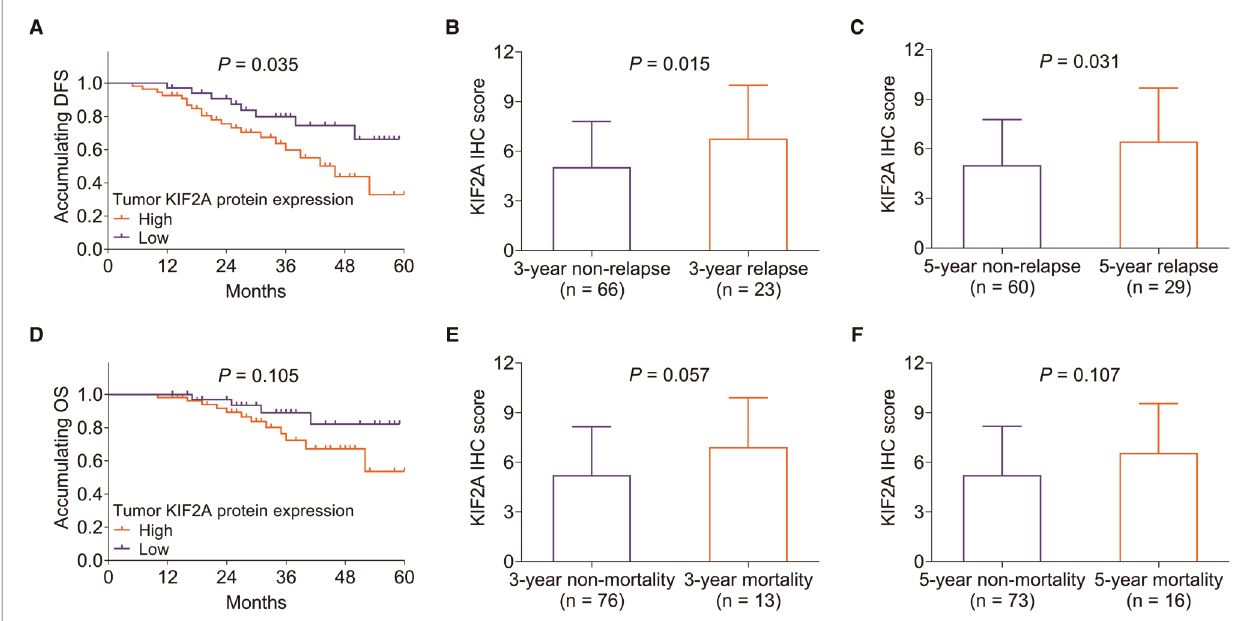
FIGURE 2 | Association of tumor KIF2A protein expression with DFS and OS. The association of tumor KIF2A protein expression with accumulating DFS in BLBC patients ( A ); the difference of KIF2A IHC score between relapsed BLBC patients and non-relapsed patients within 3 years ( B ) and 5 years ( C ). The association of tumor KIF2A protein expression with accumulating OS in BLBC patients ( D ); the difference in KIF2A IHC score between BLBC deaths and survivors within 3 years ( E ) and 5 years ( F ). KIF2A, kinesin family member 2A; IHC, immunohistochemistry; BLBC, basal-like breast cancer; DFS, disease-free survival; OS, overall survival.